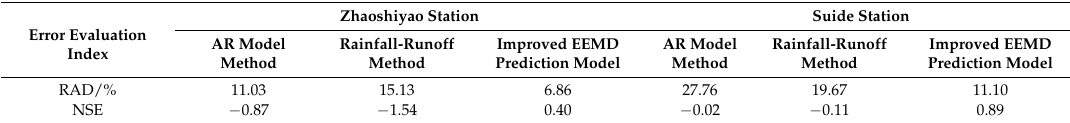
Table 3. Error assessment of forward prediction by three models.